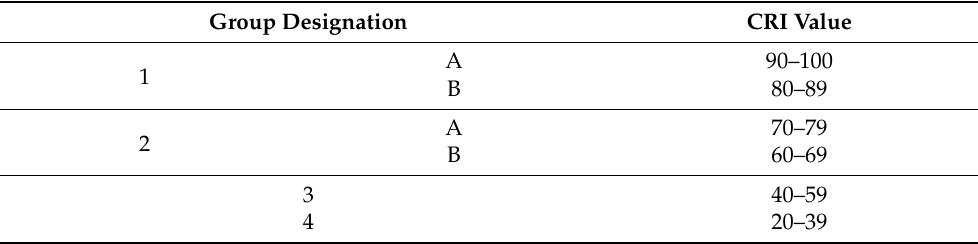
Table 2. Color rendering index (CRI).